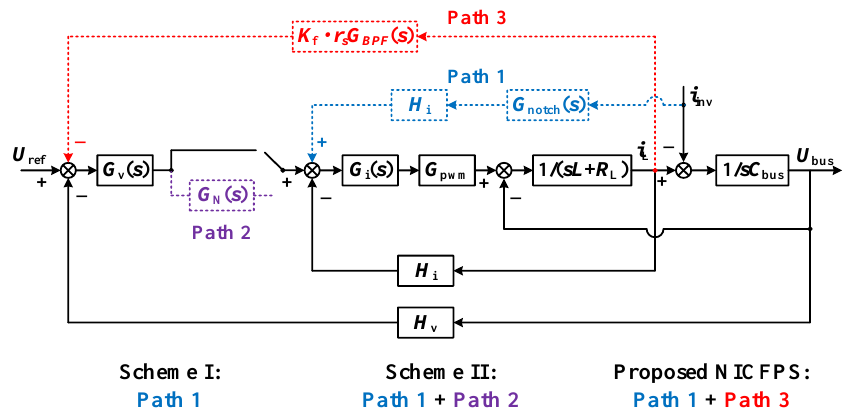
Figure 10. Control block diagram of the three schemes: Scheme I and Scheme II are both from Reference [22].